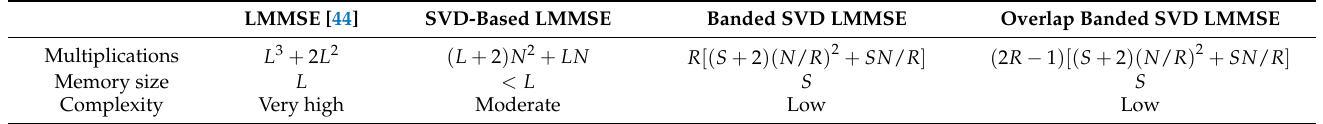
Table 3. Complexity